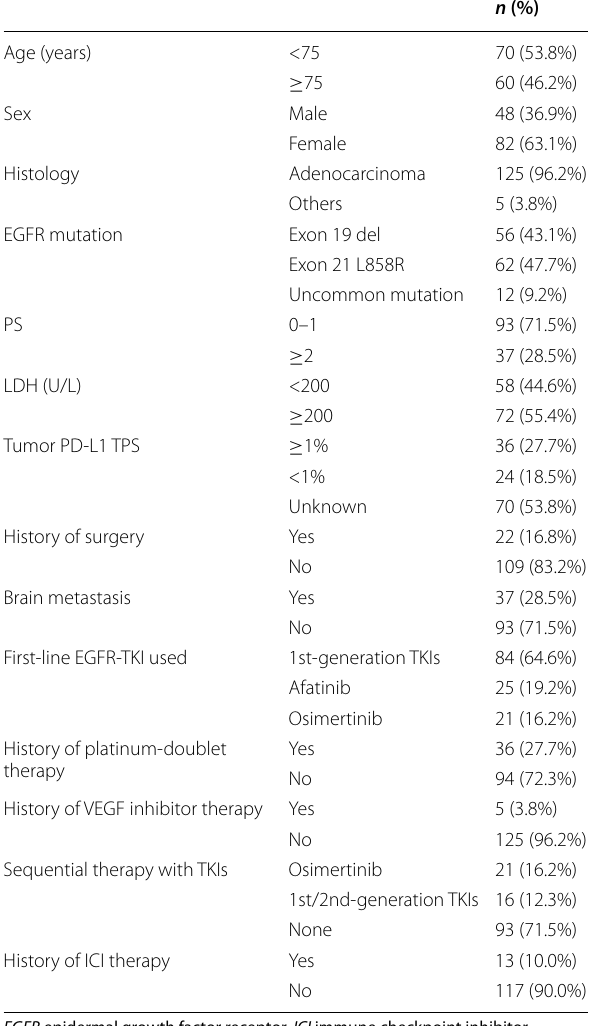
Table 1 Patient